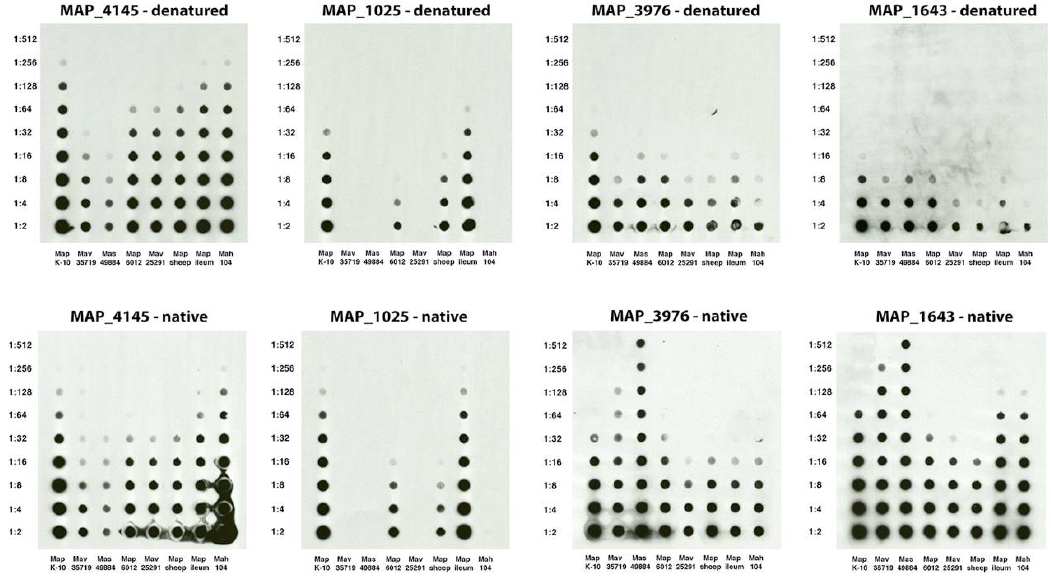
Figure 6. Relative abundance of select Map proteins in whole cell extracts of mycobacteria. Shown are a series of identically loaded dot blots with dilutions indicated in the left margin and MAC complex strain indicated beneath each blot. The protein detected and condition tested are shown above each blot. Note that relative abundance of each protein can be determined across each prep and between preps.